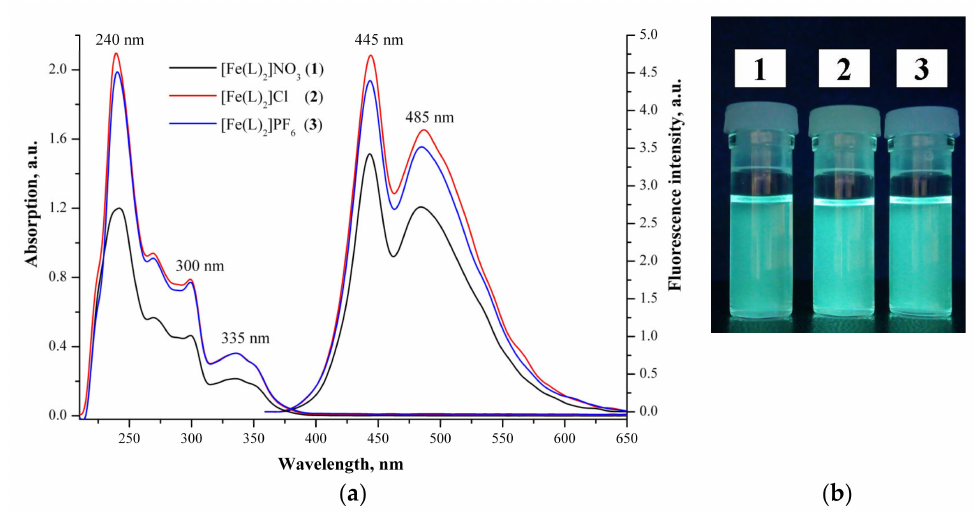
Figure 2. The absorption and fluorescence spectra of compounds 1–3 in dichloromethane, 5 × 10 − 6 mol/L, λ exc = 350 nm, T = 298.15 K ( a ), and their photographic images in CH 2 Cl 2 solution ( b